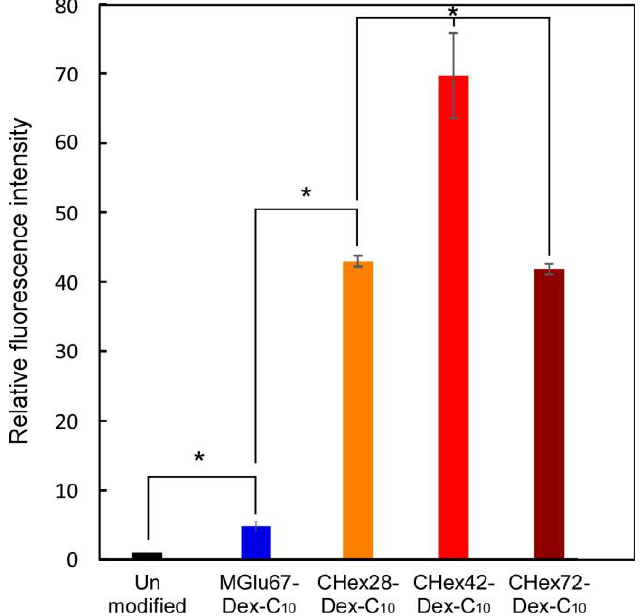
Figure 7. Relative fluorescence intensity for DC2.4 cells treated with DiI-labeled liposomes modified with or without 30 wt % MGlu67-Dex-C 10 or 10 wt % CHex-Dex-C 10 having various amounts of CHex groups. DC2.4 cells were incubated with liposomes for 4 h at 37 °C in serum-free medium. * p < 0.01.